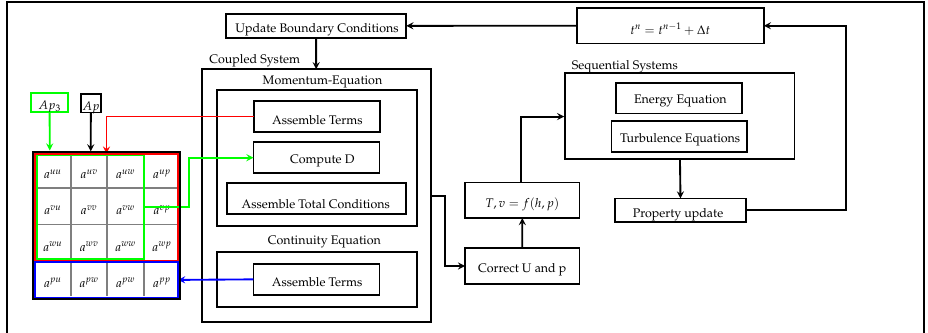
Figure 3. Flow chart of the